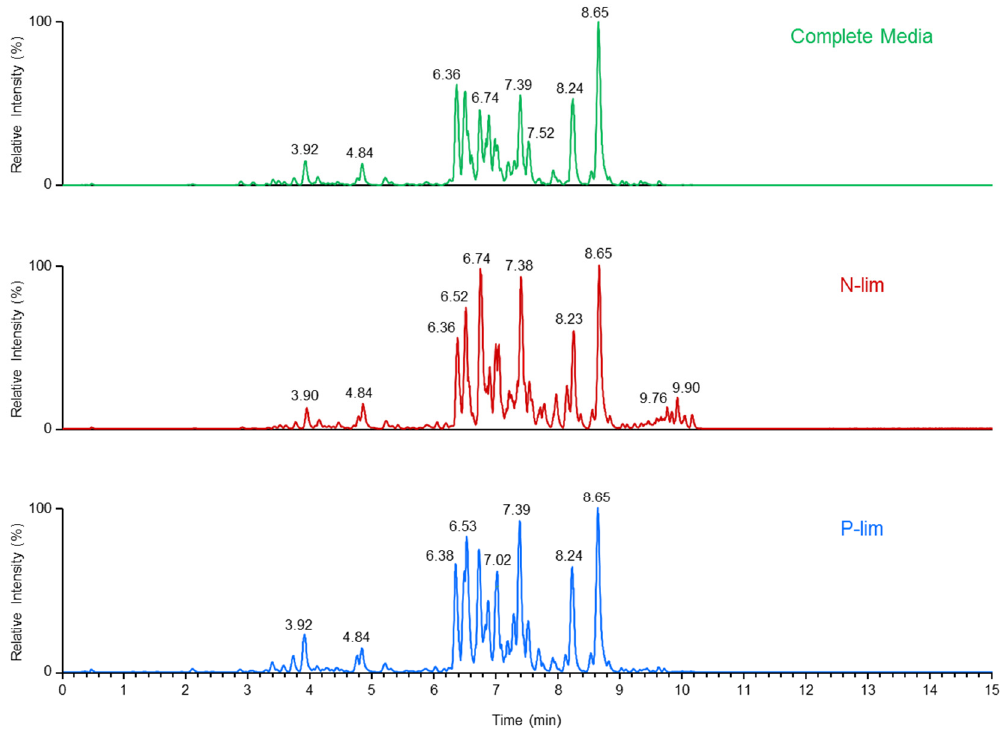
Figure 4. Representative LC-MS chromatograms of lipid profiles of O. tauri . Lipids were analysed in positive ion mode. Highly reproducible elution profiles were observed for algae grown in the different culturing conditions. The lipidomic analysis revealed the presence of a variety of polar and non-polar lipids.